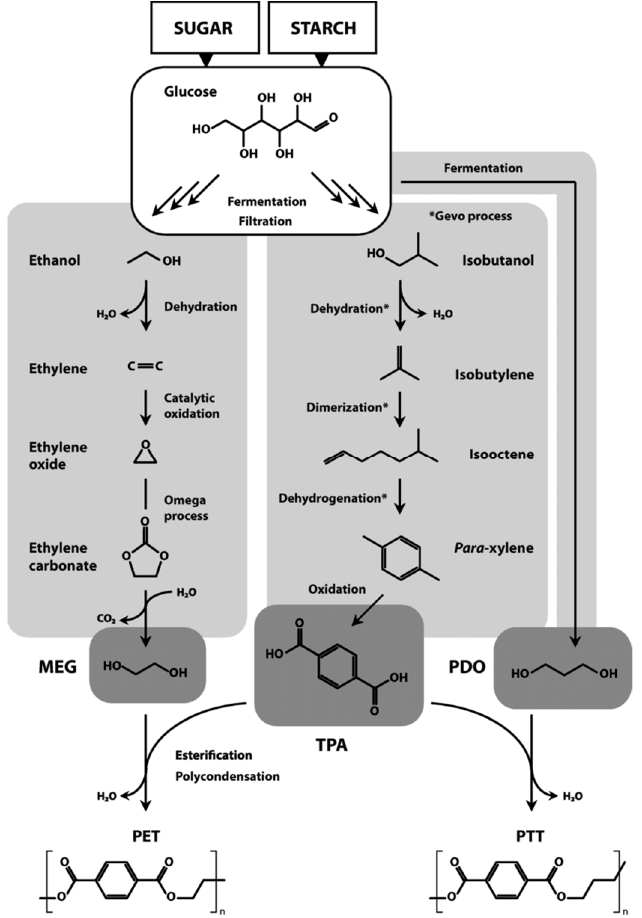
Figure 7. Production routes for fully biobased polyethylene terephthalate (PET) and polytrimethylene terephthalate (PTT). Biomass-derived substrates are marked by white boxes, biobased synthesis of monomers is highlighted in light gray, key monomers in dark gray. Abbreviations: MEG, monoethylene glycol; PDO, 1,3-propanediol; TPA, terephthalic acid [277].